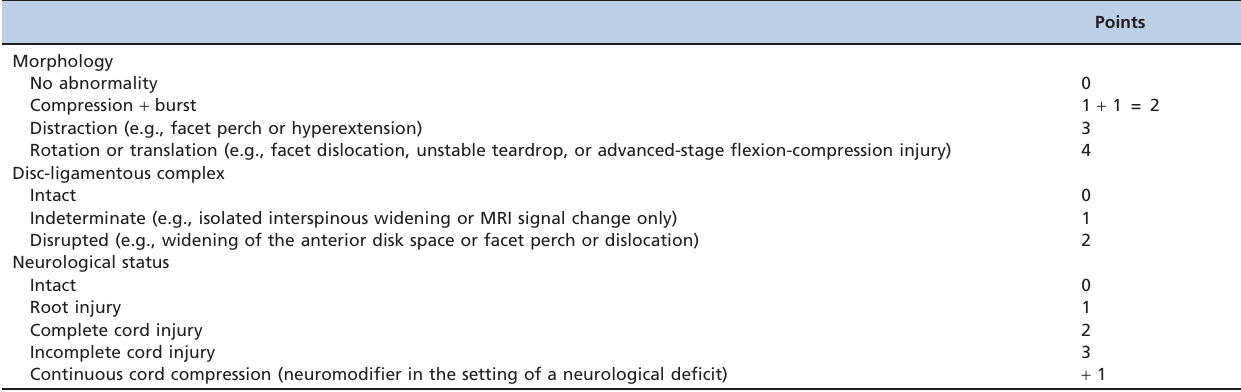
Table 1 - Subaxial Injury Classification (SLIC)